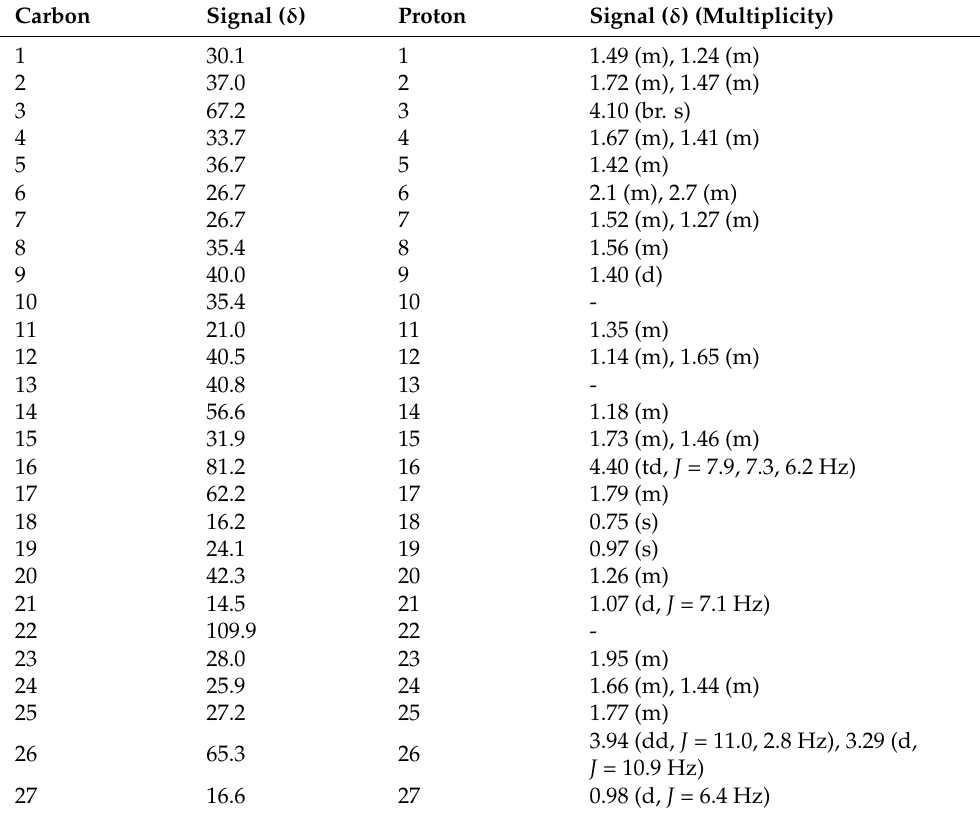
Figure 1. Chemical structure of sarsasapogenin. Each carbon atom’s numbering system is displayed in the structure. A hydroxyl group is attached at the C3 position (in purple). At the other end of the rings C-25, a chiral atom is bound to a methyl group (C-27) in the S-configuration (in red). Table 2. 1 H-NMR and 13 C-NMR data for sarsasapogenin in deuterated chloroform (CDCl 3